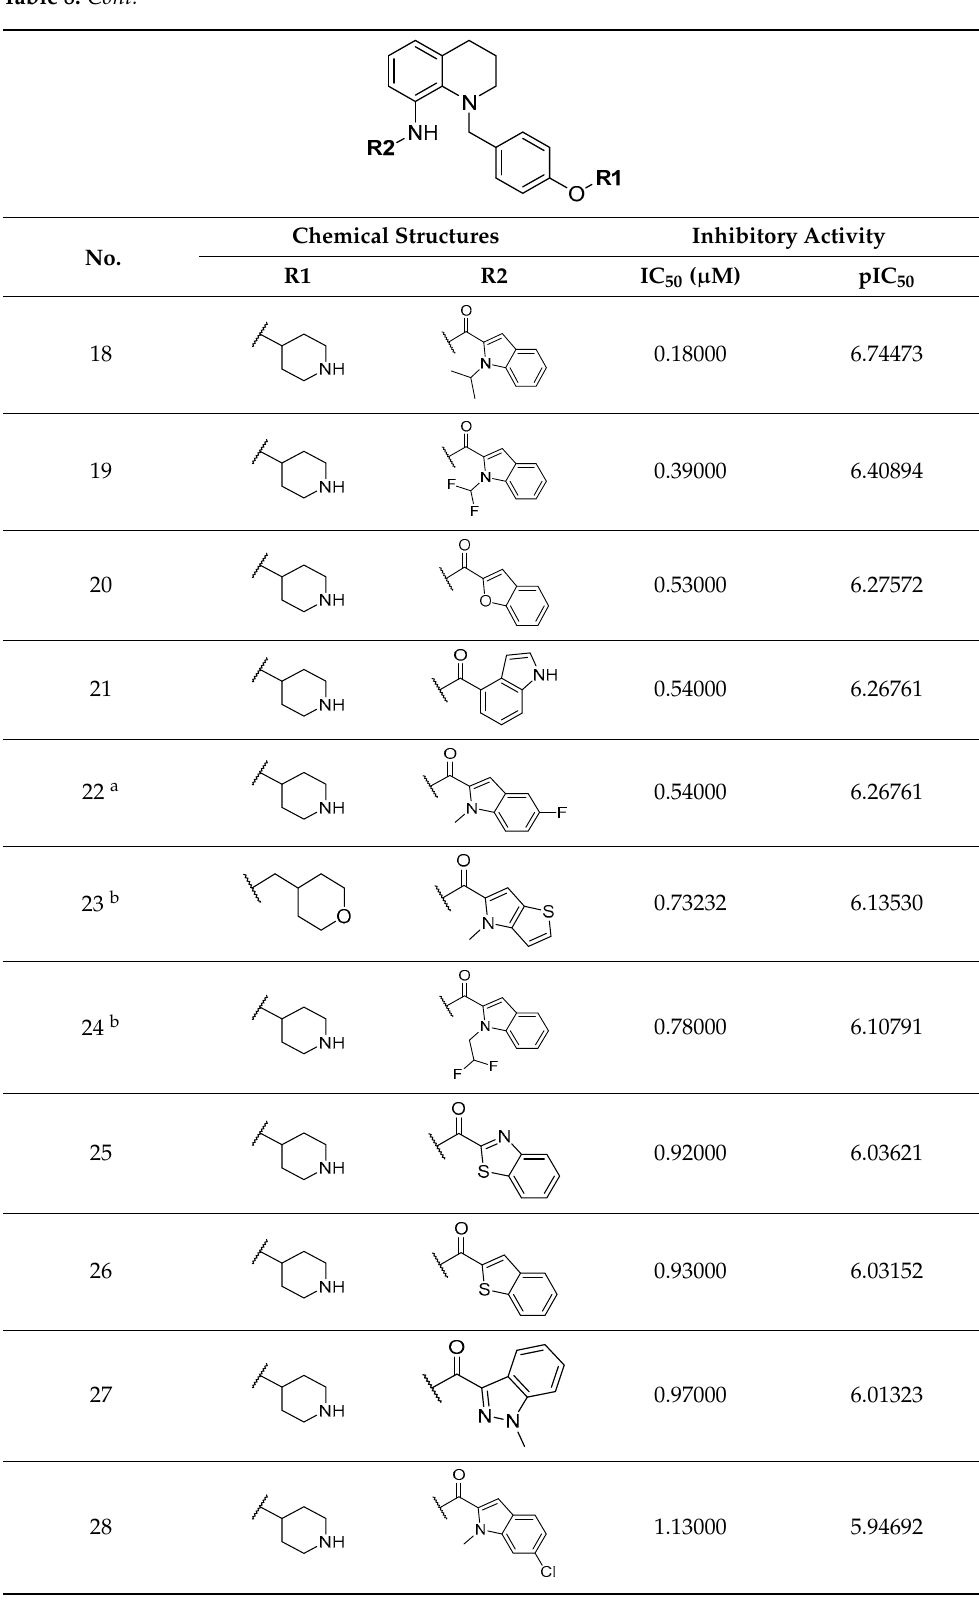
Table 8. Cont. Table 8. Structures and inhibitory activity of tetrahydroquinoline